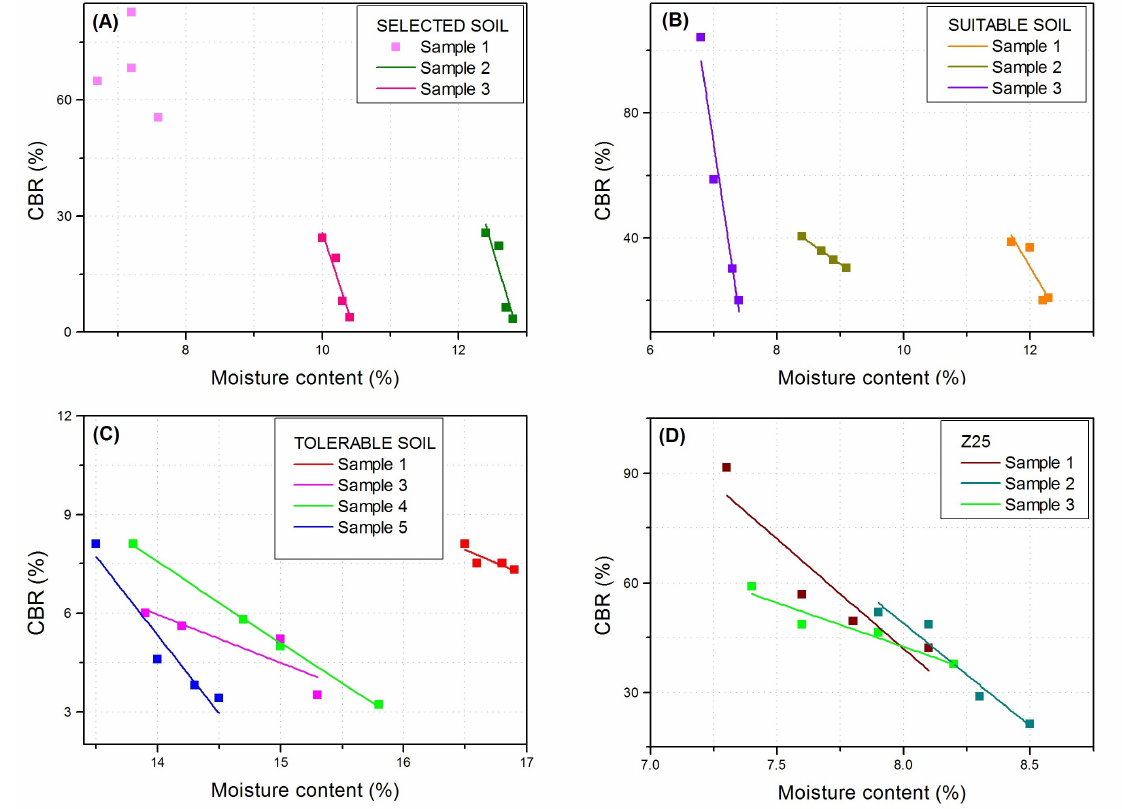
Figure 5. CBR versus moisture content for ( A ) selected soils, ( B ) suitable soils, ( C ) tolerable soils and ( D ) Z25 (artificial crushed graded soil).